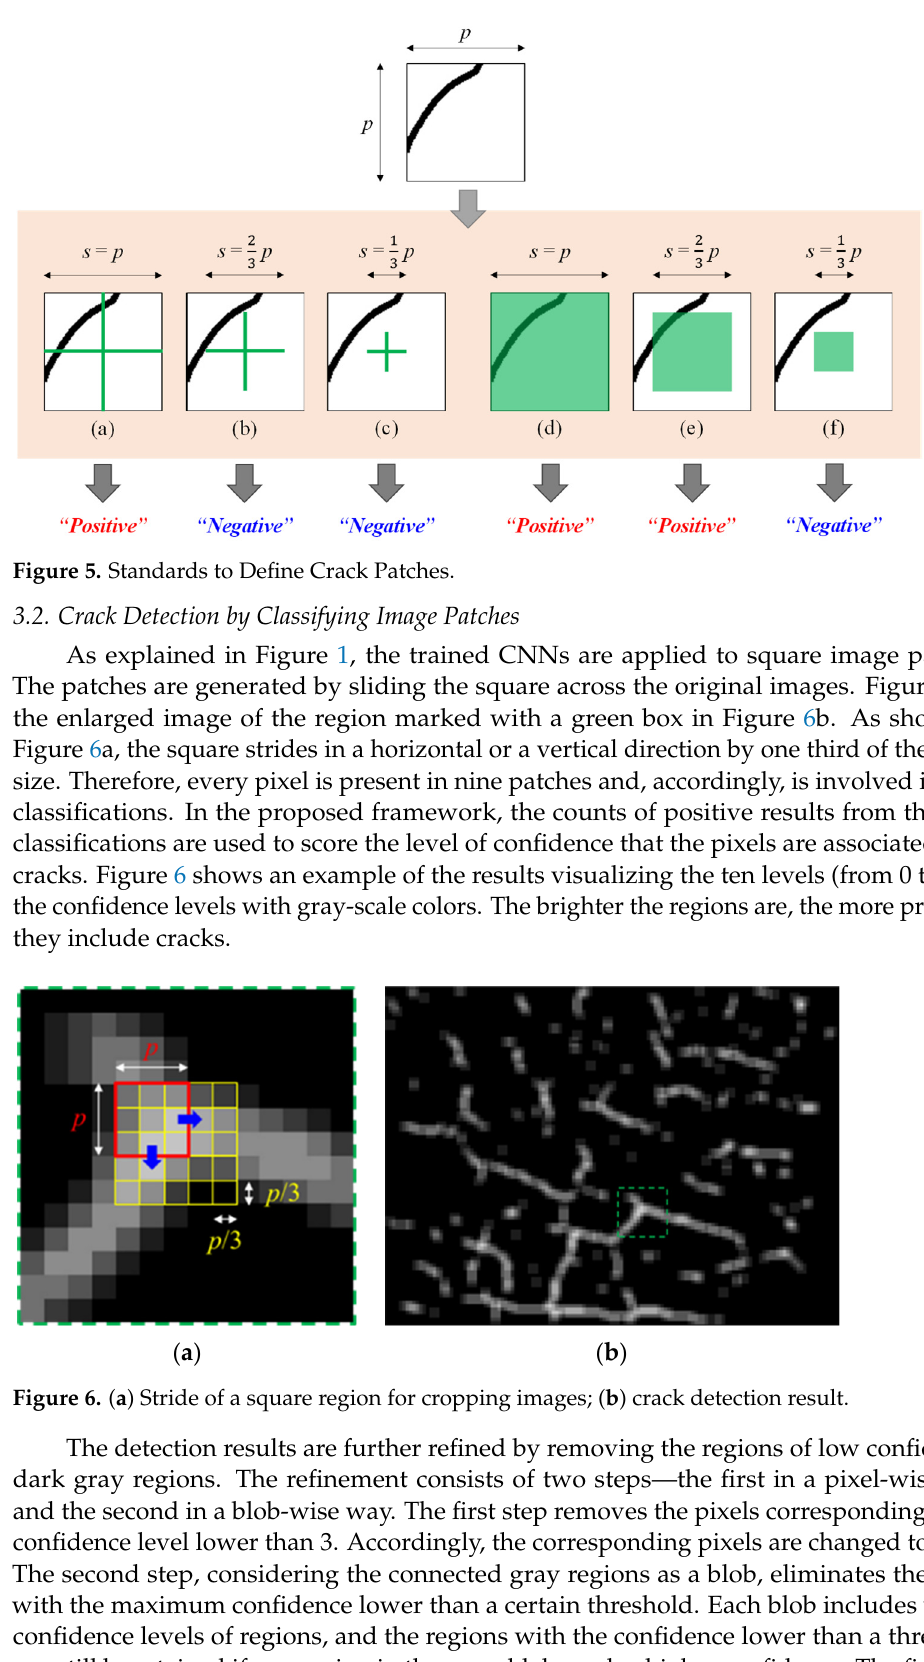
Figure 7. (1st row) Results of fi ltering pixels and blobs with varied thresholds; (2nd row) results of thinning blobs. 3.3. Length Estimation While the crack widths are barely measurable from the images, their length can be estimated based on the detection results. As a fi rst step to estimate the lengths of the cracks, the re fi ned blobs are transformed into one-pixel wide lines. For this purpose, this paper used the morphological-thinning algorithm [43], which progresses by successively rounding o ff the boundary pixels on the side of north, east, south, and west, in turn. The second row of Figure 7 demonstrates the results of thinning the images in the fi rst row. It can be observed that the thinning process e ff ectively carry out the conversion to lines while keeping the blobs’ original curved shapes. The length of a crack line extracted from each blob can be measured by tracing the connected pixels of the line from one end to the other end. As shown in Figure 8, the pixels on the line adjoin each other vertically, horizontally, or diagonally. The length segment between two pixels connected in a vertical or horizontal direction is measured as one pixel while those connected diagonally is measured as √2 (Figure 8a). Accordingly, by tracing the pixels one by one and accumulating the length segment, the total length of a crack can be directly calculated. For each crack, the pixel with the lowest y coordinate, which corre- sponds to the top-most point, is chosen for the start of the tracing. During the tracing, black neighbor pixels of the current position, if any, are found and the length segment is calculated based on whether the black pixel is positioned horizontally, vertically, or diag- onally.